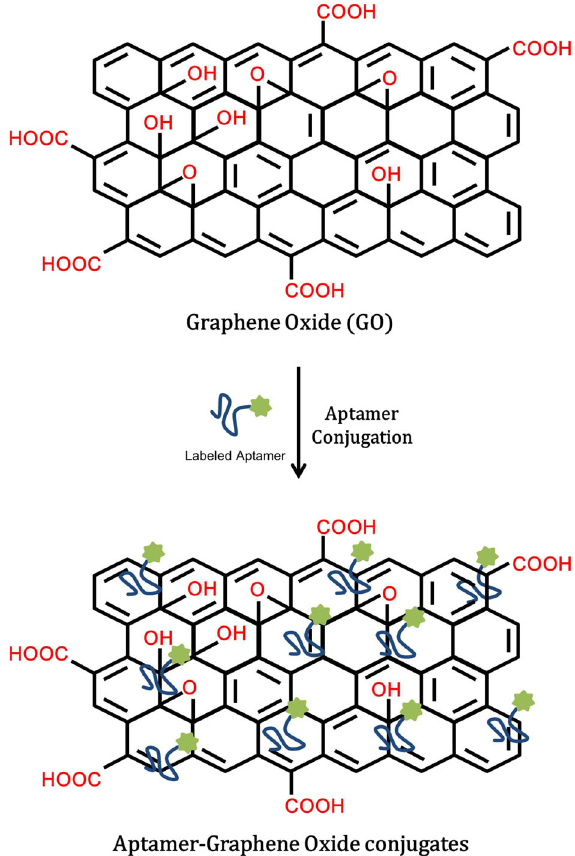
Fig. 6 GO – aptamer conjugation. Illustration of the conjugation of GO with aptamer to obtain GO – aptamer conjugate-sensing